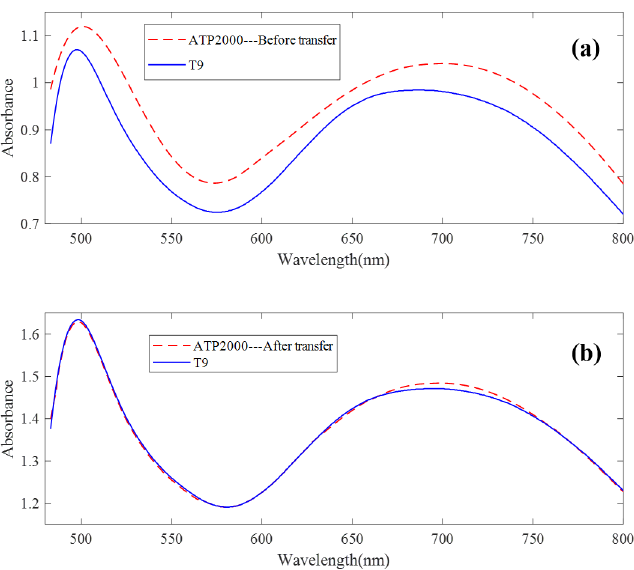
Figure 8. The spectral transfer result of the method. ( a ) The difference in spectral absorbance between the two instruments when measuring the same sample. ( b ) The spectrum measured by the slave instrument and the master spectrum after